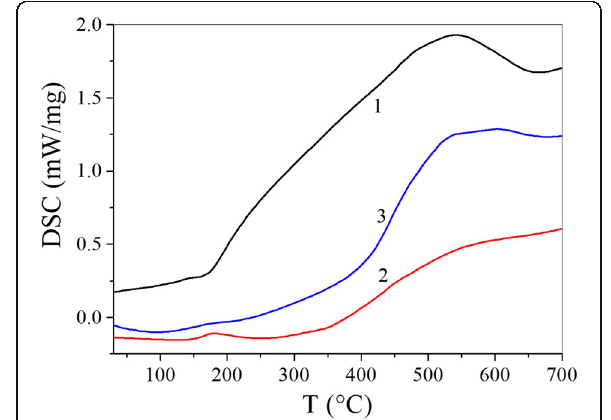
Fig. 3 Differential scanning calorimetry curves of Cu-Ti ( 1 ), Cu-Ti 1 vol% MWCNTs ( 2 ) and Cu-Ti 3 vol% MWCNTs ( 3